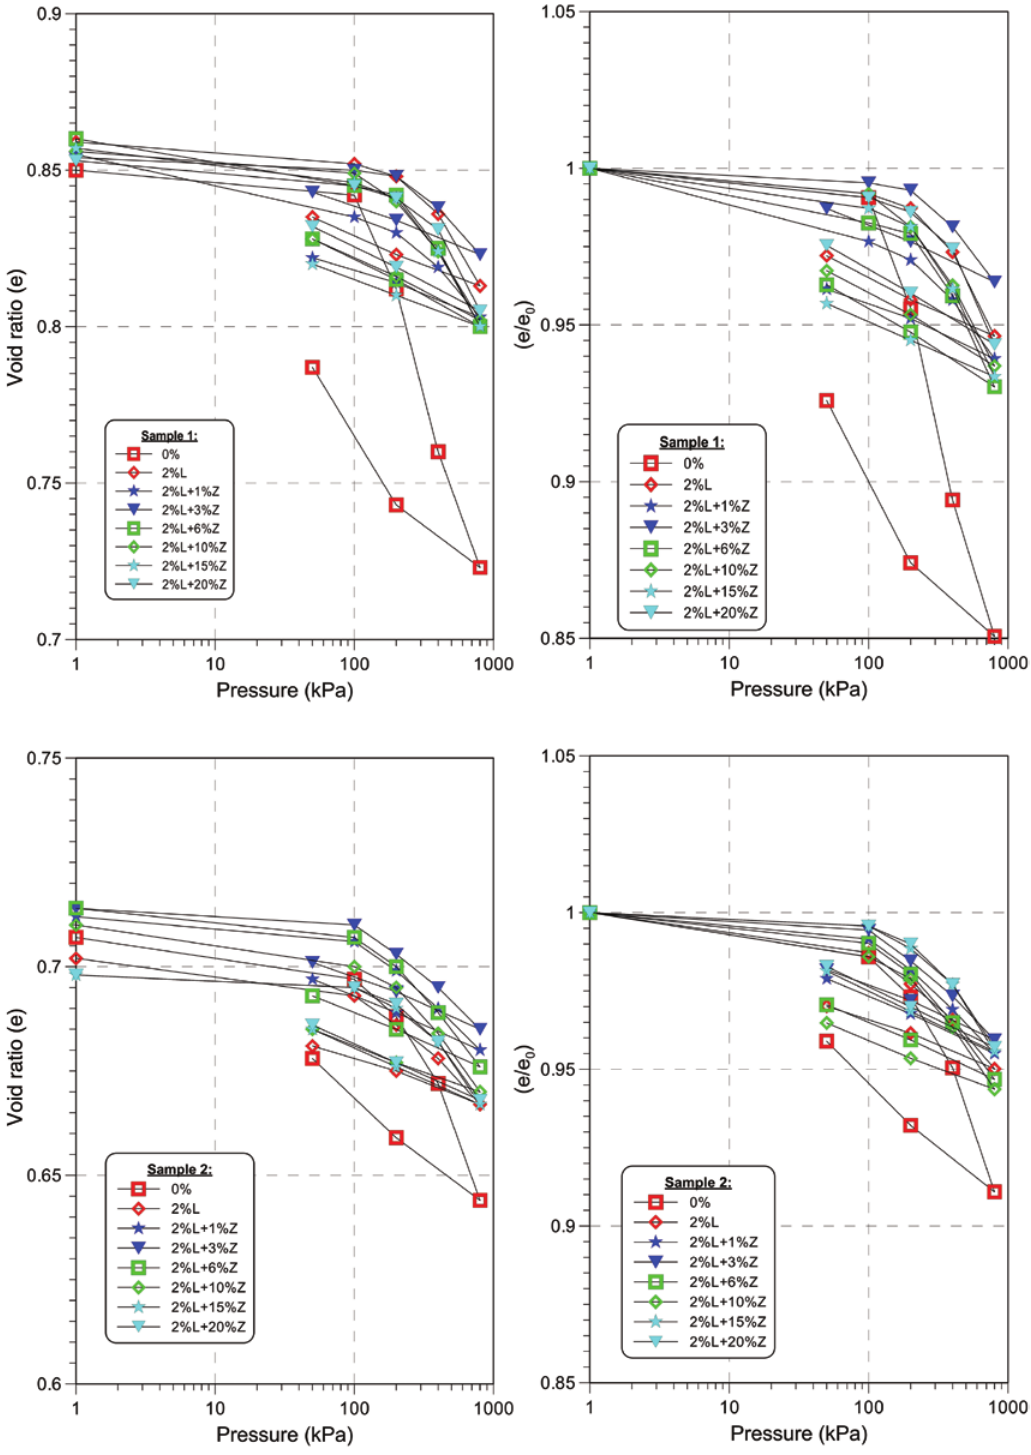
Figure 6: The conventional and modified compression curves for soil samples mixed with different additive contents.